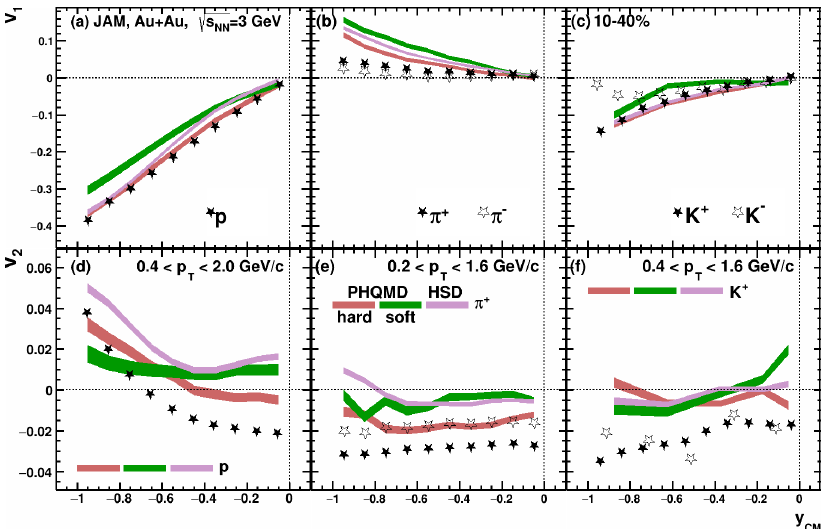
Figure 12. Rapidity ( y cm ) dependence of v 1 ( a – c ) and v 2 ( d – f ) of proton ( a , d ), charged pions ( b , e ) and √ s NN = 3.0 GeV. The symbols denote the charged kaons ( c , f ) in 10–40% central Au + Au collisions at published data from the STAR experiment [15]. The red and green bands represent the results from PHQMD model with hard ( K 0 = 380 MeV) and soft ( K 0 = 200 MeV) EOS, respectively. The purple bands represent the results from the HSD model. The uncertainties of the simulated model data are